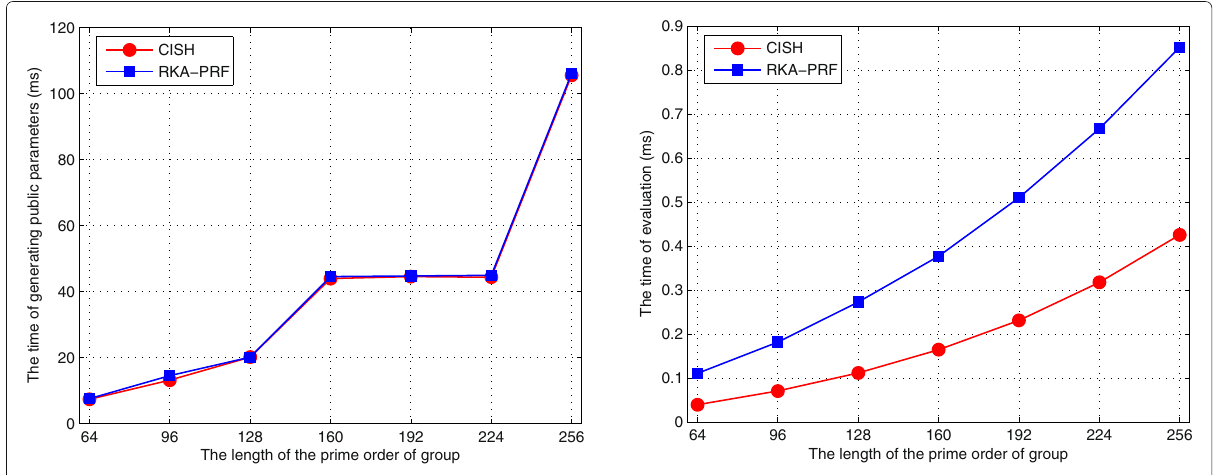
Fig. 2 Z N where N is prime. a The time of generating PP b The time of evaluation